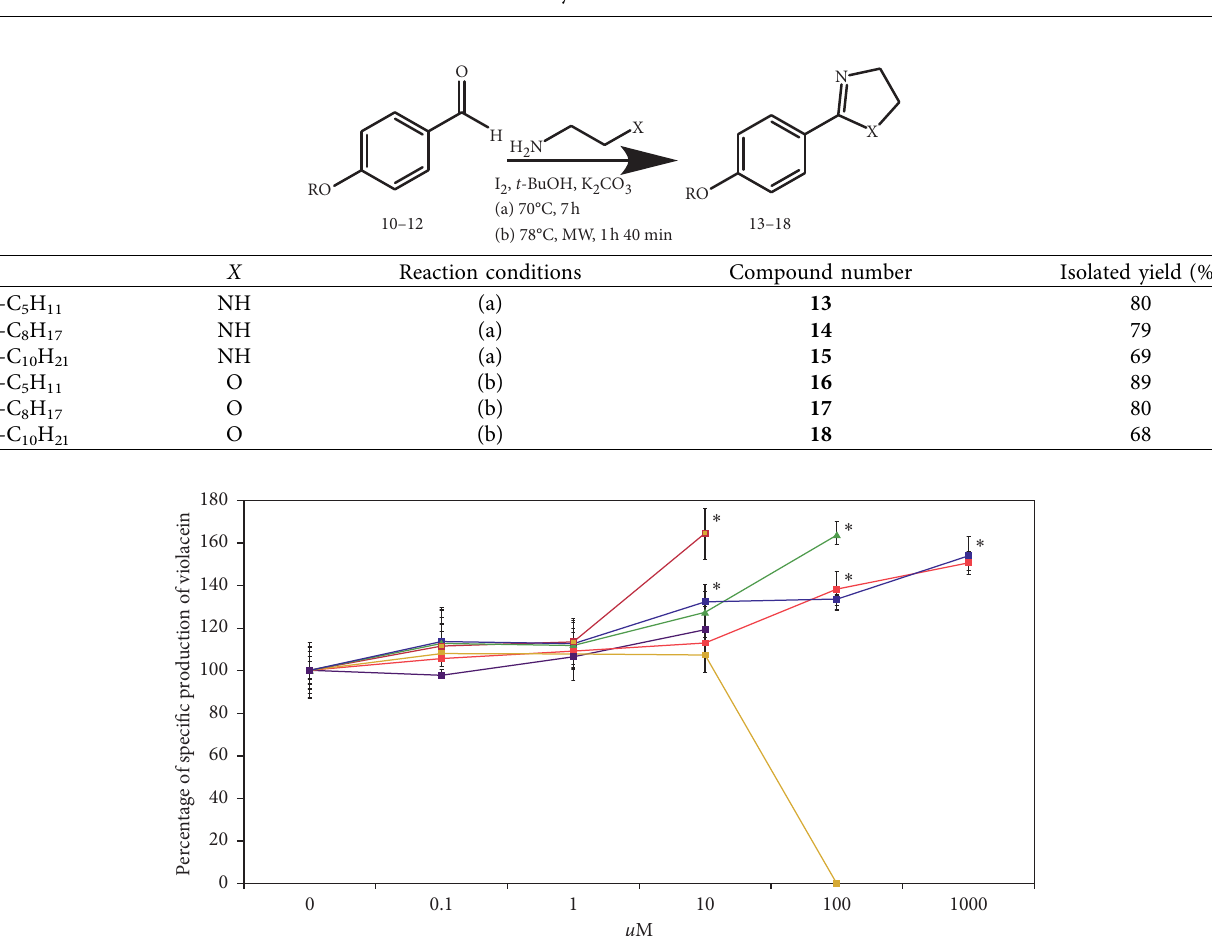
Figure 1: C 6 -AHL ( 1 ) and some known quorum-sensing inhibitors ( 2 – 9 ). Table 1: Synthesis of azolines.